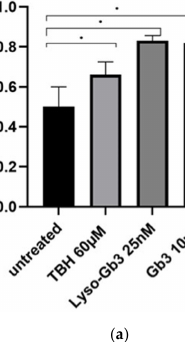
( b ) Figure 8. Lyso-Gb3 and GB3 effect on HUVECs senescence. Senescence status was estimated by SA- β -Gal assay in HUVECs treated with TBH 60 µM, Lyso-Gb3 25 nM, and Gb3 10 µM. Images are representative of ten random fields ( a ). Data are expressed as % of SA-b-Gal positive cells and are the means ± SD ( b ). Comparison among multiple groups was analyzed by one-way analysis of variance, followed by Bonferroni’s post hoc test. * p < 0.01.